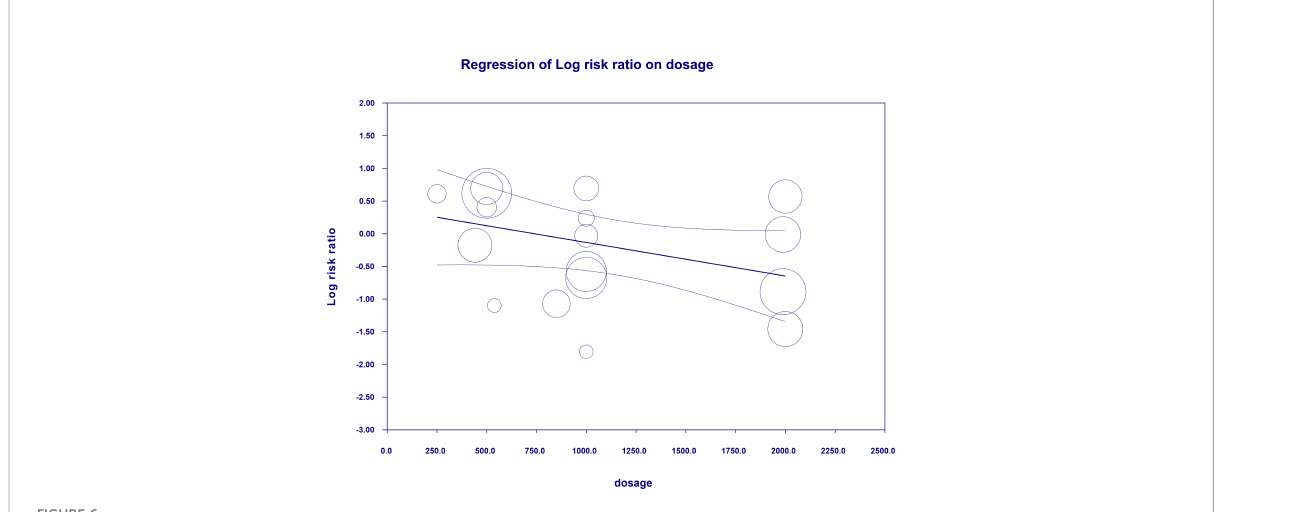
FIGURE 6 Regression for RR toward constipation by